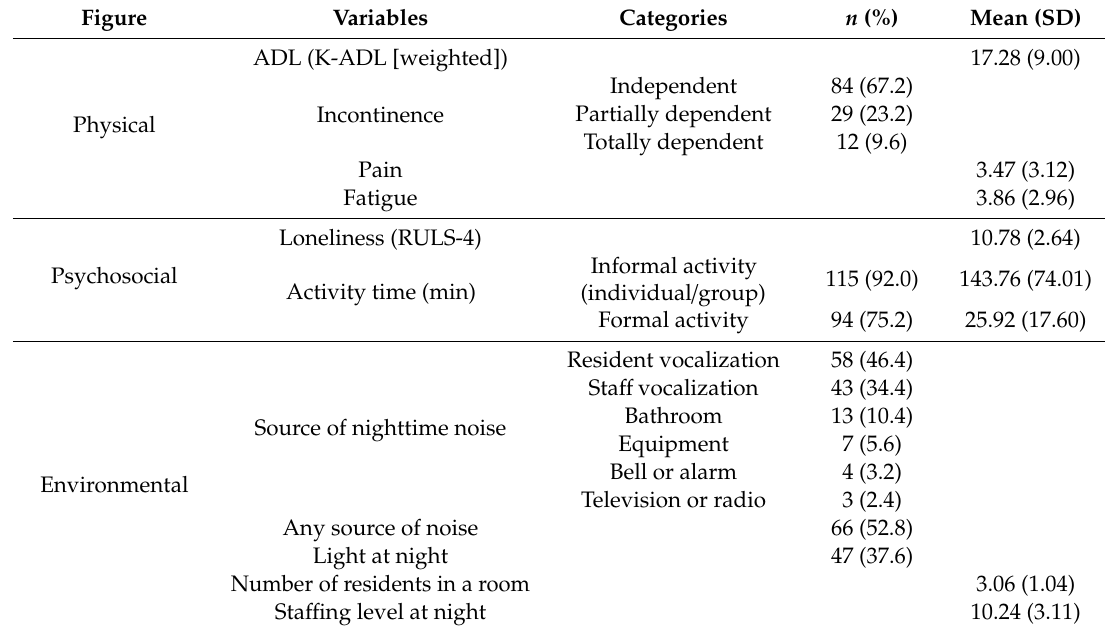
Table 2. Physical, psychosocial, environmental characteristics of the participants ( n = 125). Figure